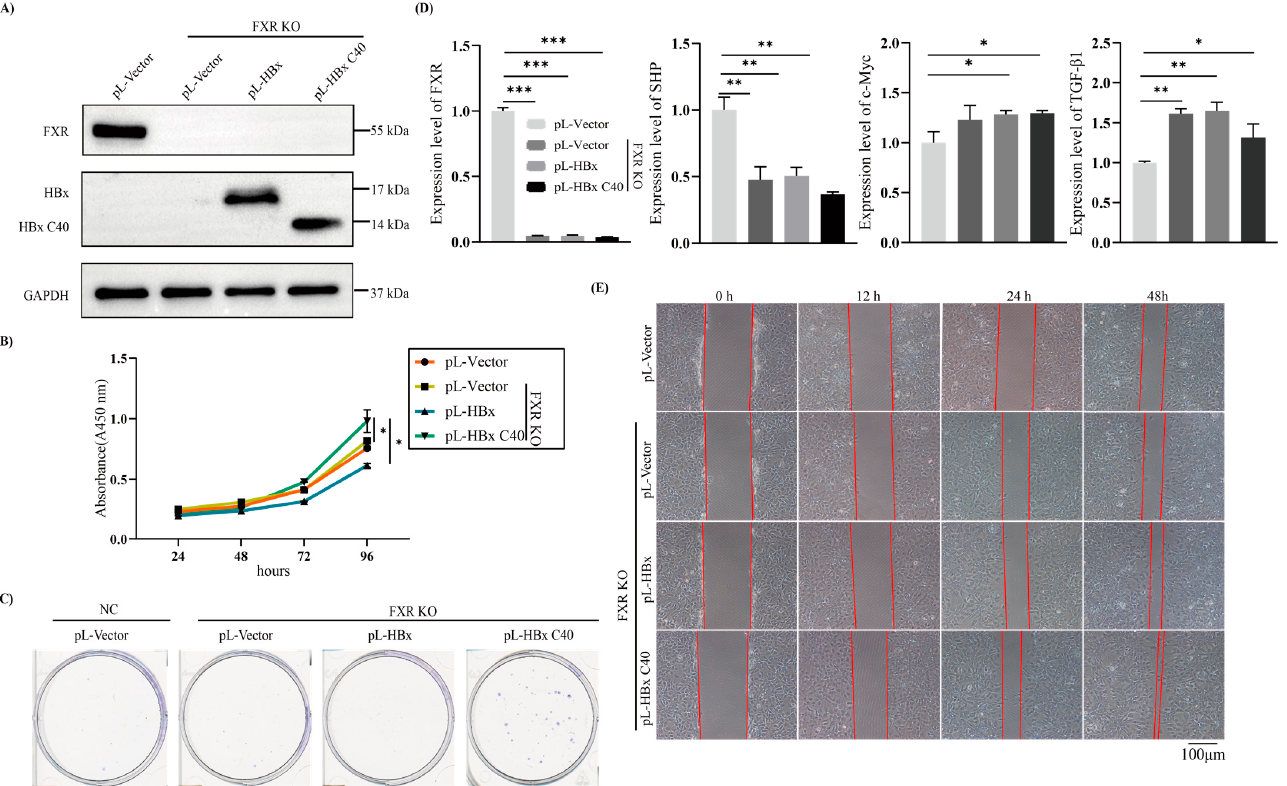
Figure 2. HBx C40 promotes cell proliferation and migration in FXR KO tumor cells in vitro. ( A ) Protein expression levels of FXR, HBx, and HBx C40. ( B , C ) Proliferation of FXR KO Hep3B cells